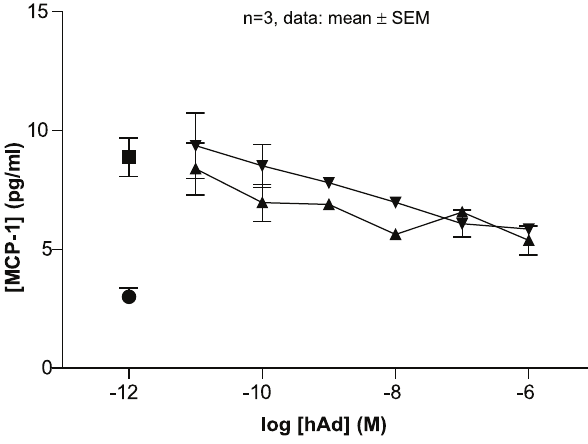
Figure 3. Inhibition of palmitate-induced MCP-1 production by THP-1 cells. hAd consistently and dose dependently inhibits the MCP- 1 release. THP-1 cells were pre-incubated with 10 pM to 1 m M hAd for 2 h and subsequently stimulated with 100 m M palmitate for 24 h. Two different batches of hAd were compared (upward- and downward- pointing triangles) with controls with (square) and without (circle) palmitate.